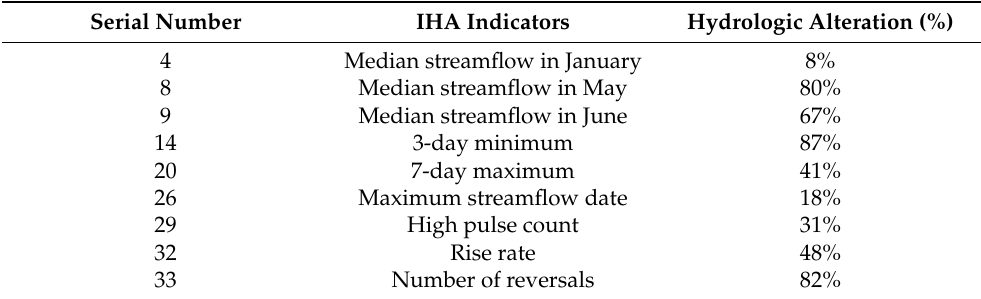
Table 6. Results of preferred indicator evaluation.